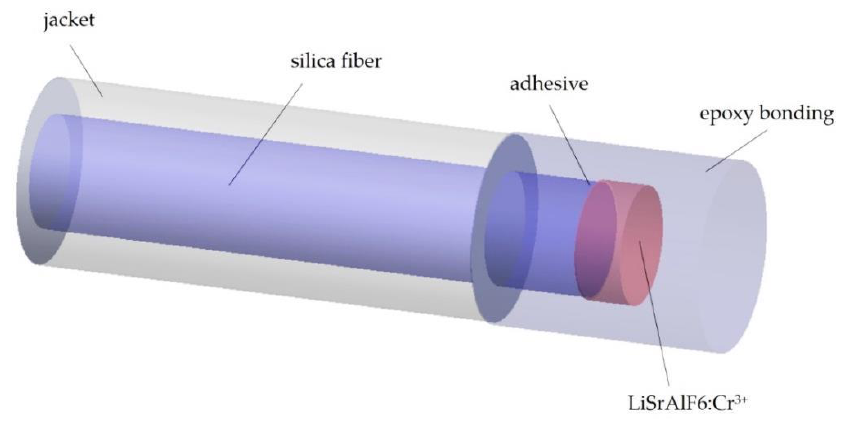
Figure 8. The probe of fiber temperature (Adapted from [145].)